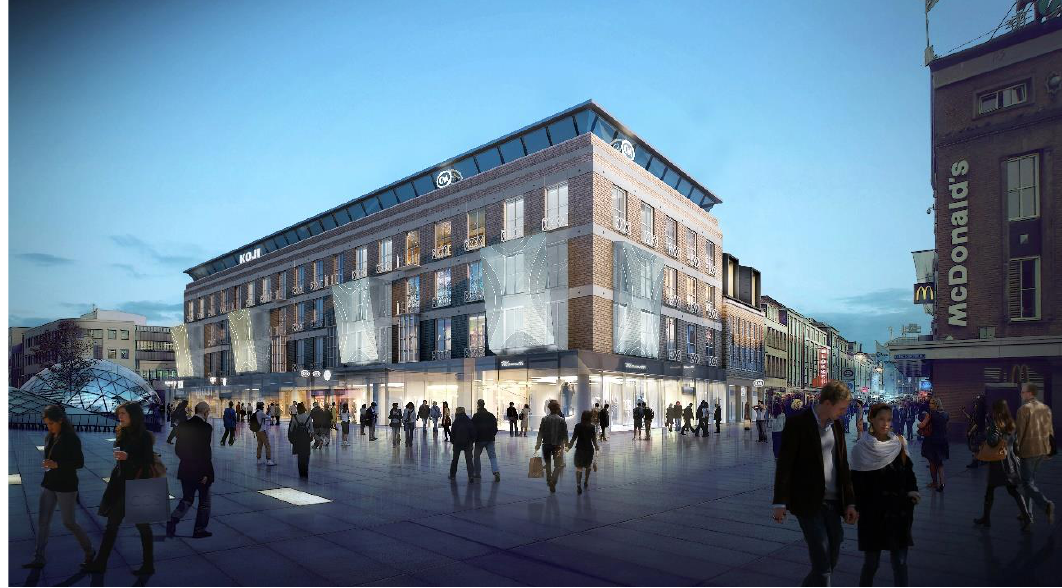
Fig. 2 18 Septemberplein,